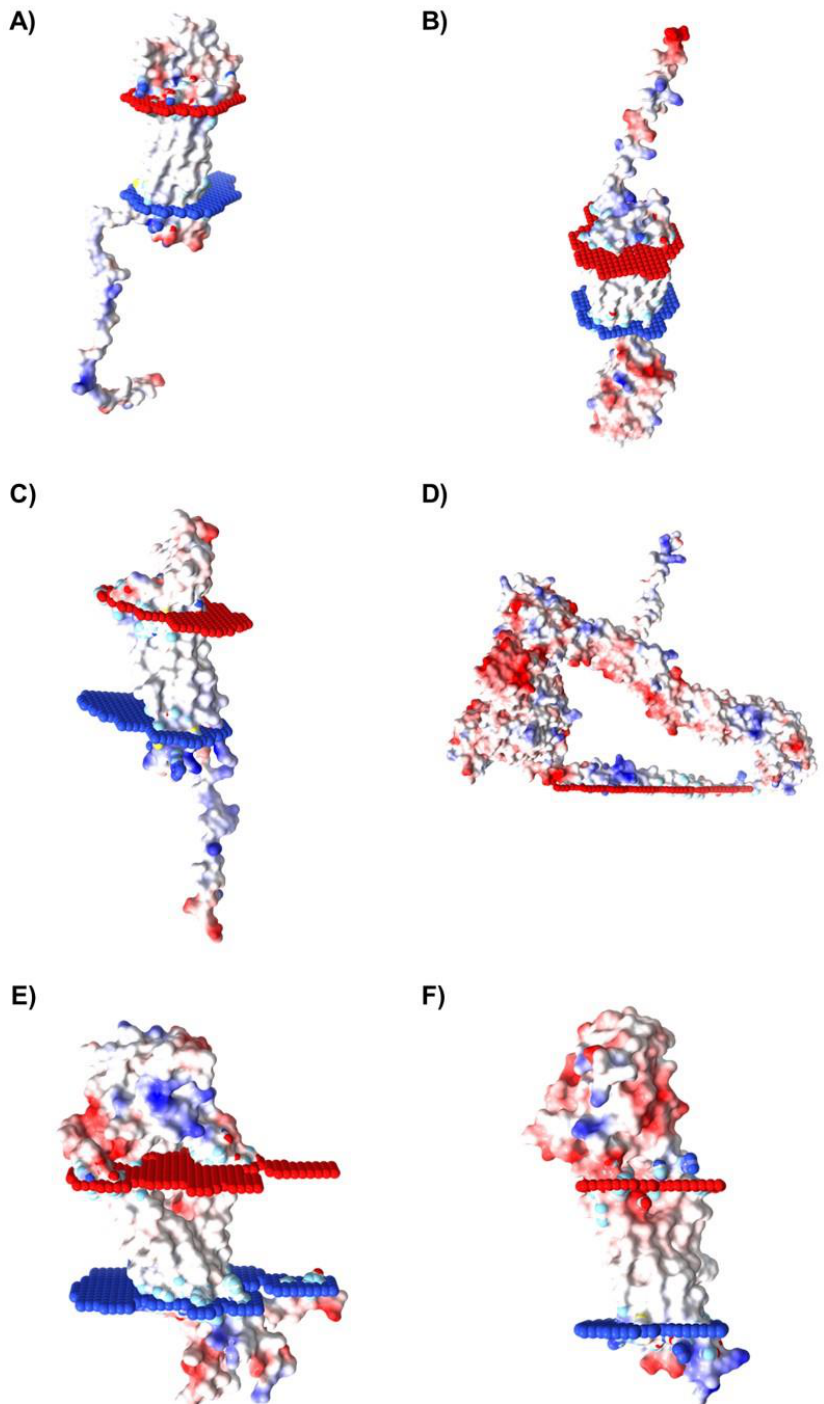
Figure 8. Membrane regions spatial distribution and electrostatic potential of proteins identified for OvCar-3 cell line. The proteins selected for OvCar-3 cells were: ( A ) CLDN6, ( B ) CD47, ( C ) CLDN7, ( D ) EPHA1, ( E ) TSPAN15, and ( F ) UPK1B. For the spatial orientation, the red portion indicates the extracellular region, and the blue portion indicates the intracellular region. For the electrostatic potential evaluation, blue color indicates a positive charge and red color indicates a negative charge.